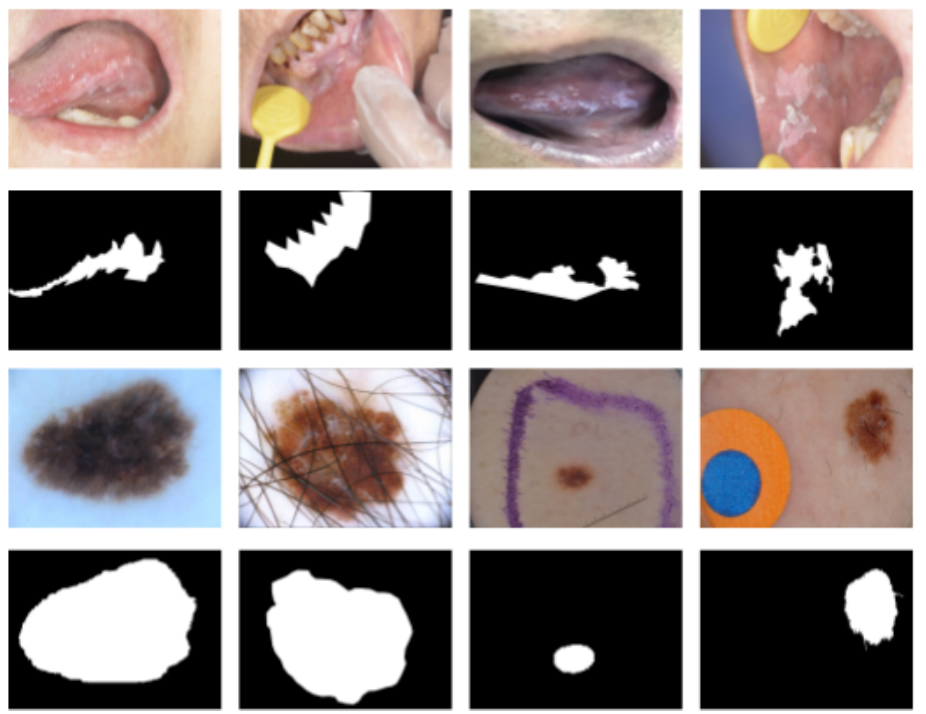
Figure 1. Some samples of lesion segmentation (The first two rows are oral leukoplakia dataset, and the last two rows are ISIC 2018